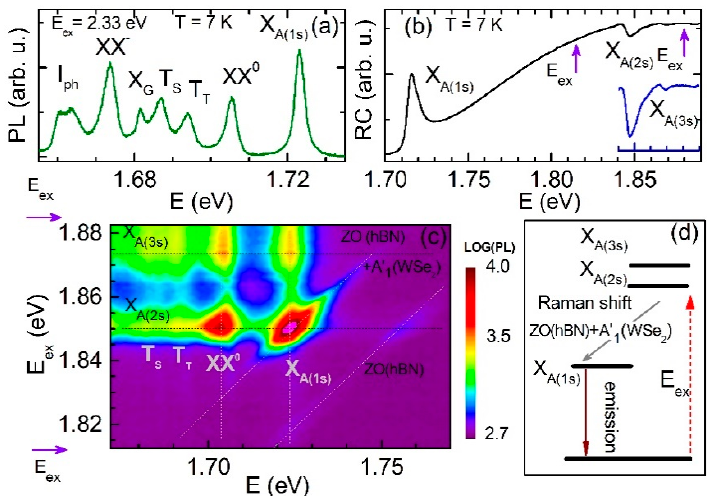
Figure 2. Unpolarized photoluminescence and reflectivity contrast spectra of hBN/WSe 2 /hBN heterostructure recorded at T = 7 K. ( a ) PL spectrum excited non-resonantly with laser energy E ex = 2.33 eV. ( b ) RC spectrum recorded at the spectral range of the A exciton transitions: 1s, 2s and 3s. Violet arrows mark the range of energy of laser excitation applied in the photoluminescence excitation experiment. ( c ) PLE spectra recorded at the energy range marked in ( b ) by violet arrows. ( d ) The schematic representation of the double resonance process.